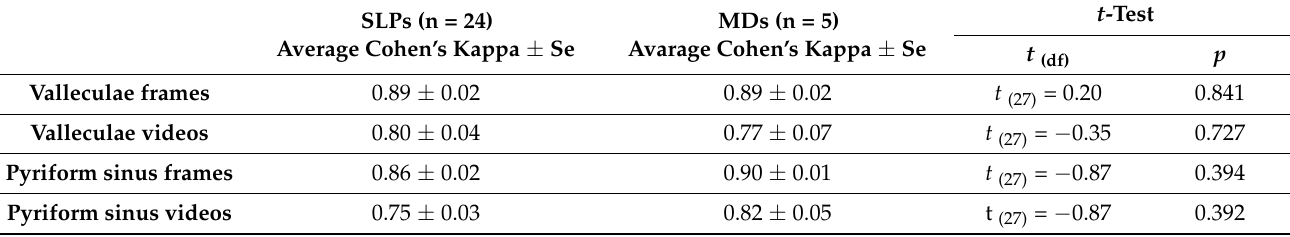
Table 6. Construct validity in frames and videos ratings across SLPs group and MDs group.